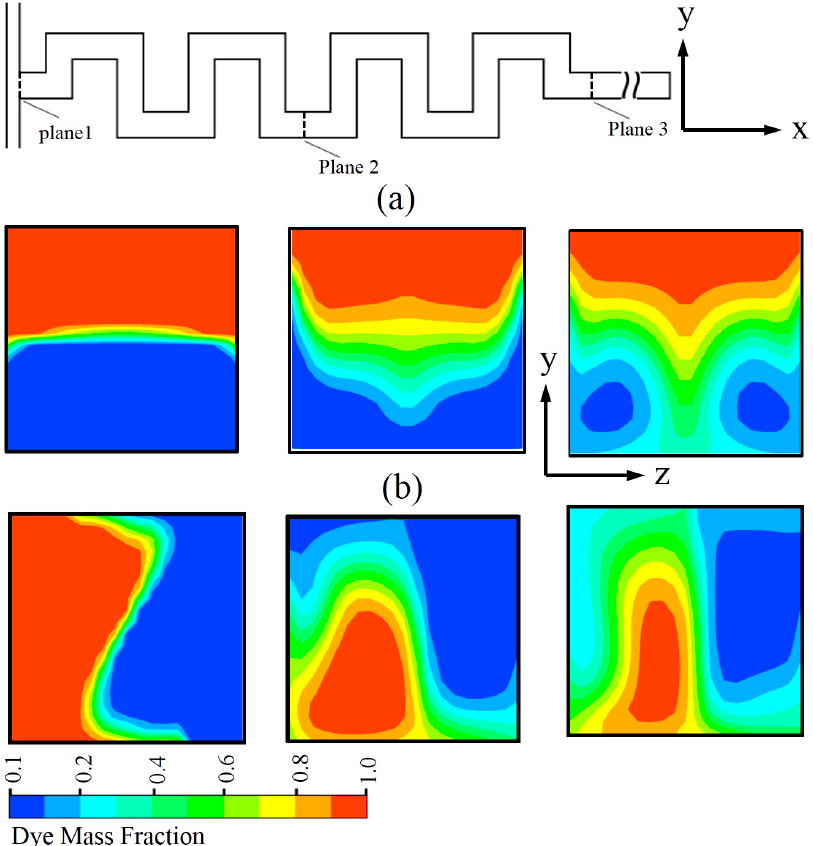
Figure 6. Dye mass fraction distributions at various y – z planes (Re = 30) : ( a ) Micromixer with simple T-joint inlet; and ( b ) micromixer with tangentially aligned input channels.